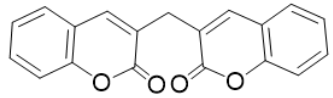
Figure 11. Chemical structure of dicoumarol.